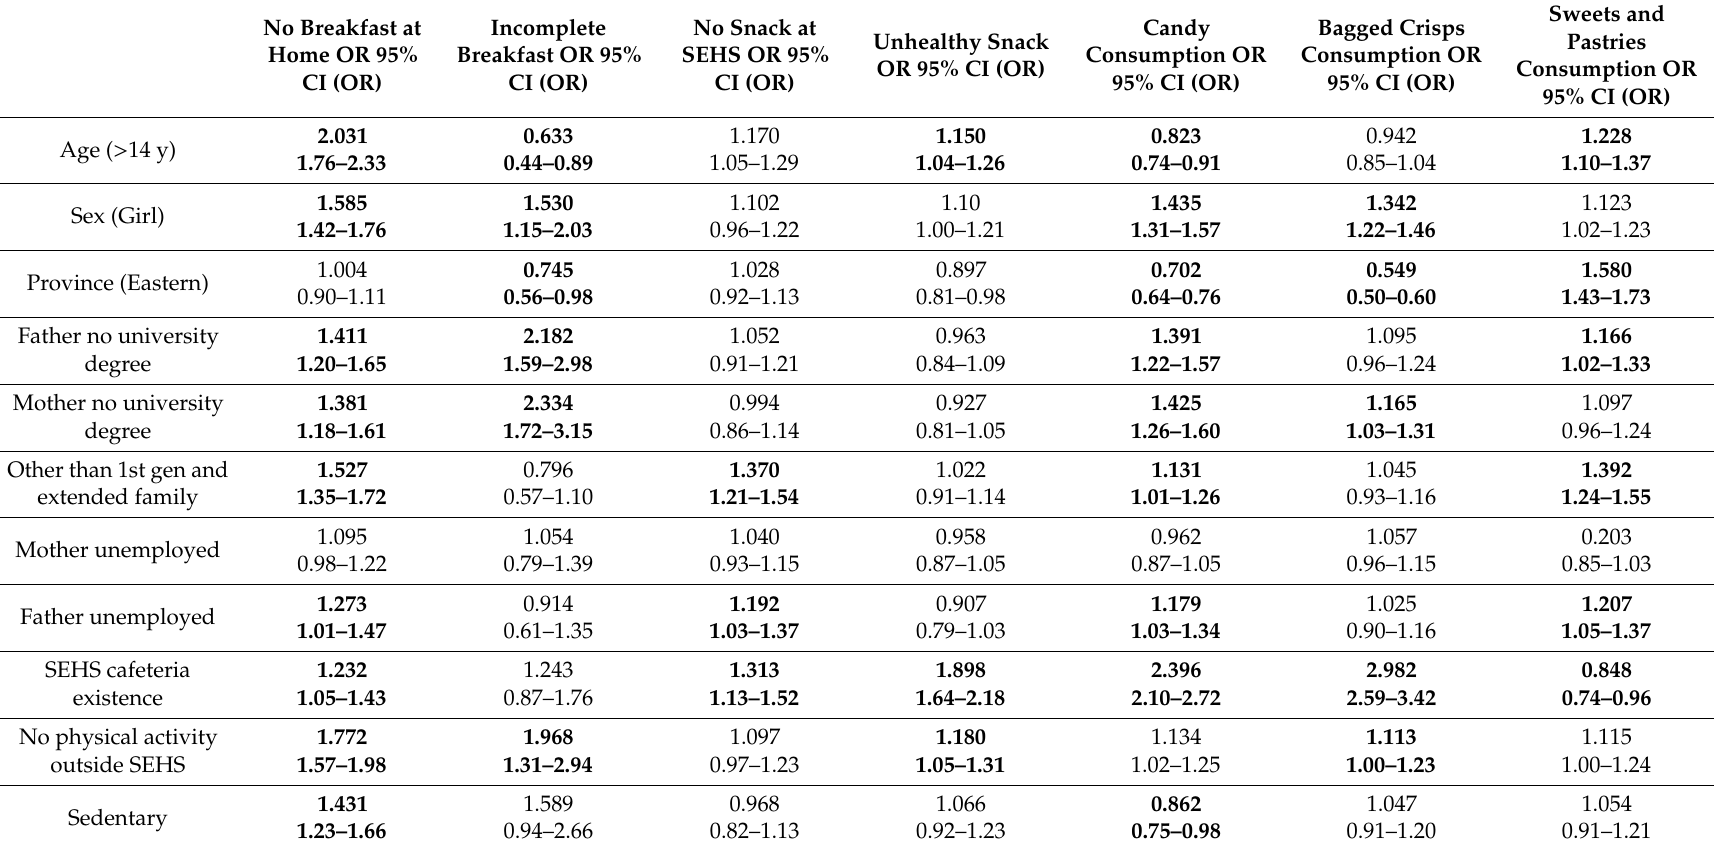
Table 5. Factors associated with eating habits during the school day